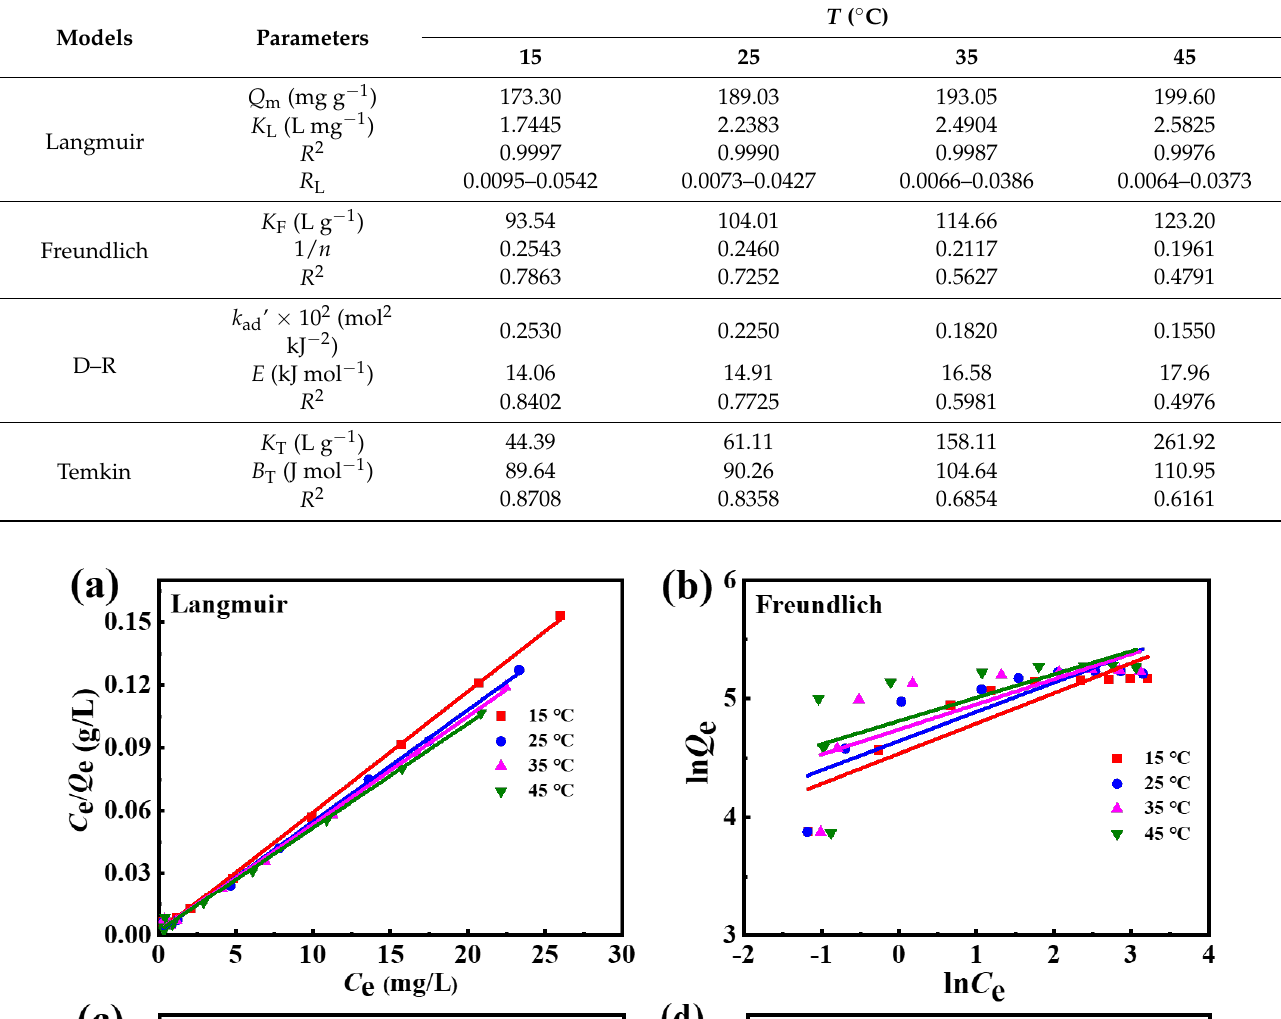
Table 1. Four classical isotherms constants for defluoridation on LMF11 NFs at 15 to 45 ◦ C.